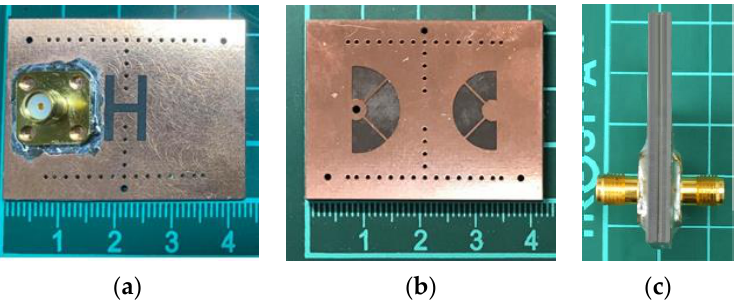
Figure 11. Photos of the experimental circuit: ( a ) the top view with one of the feeding SMAs; ( b ) the layer containing the coupling apertures; and ( c ) the side view.